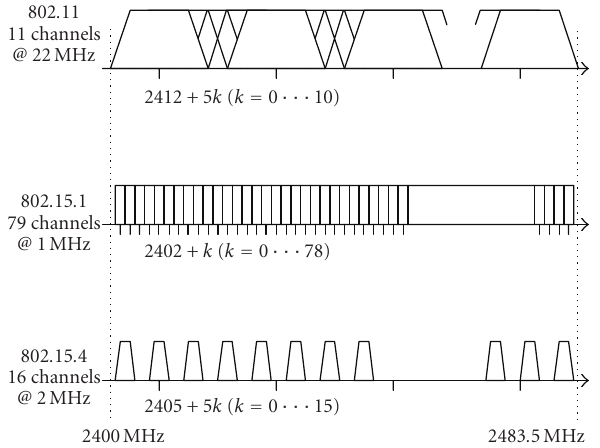
Figure 3: Used spectra of wireless LAN and PAN technologies in ISM